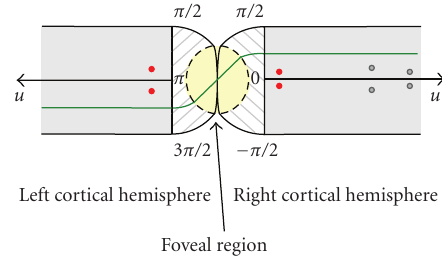
Figure 10: Schematic depiction of the global retinotopy with the peripheral region (gray) and the foveal region (yellow). Shaded in gray lines is the perifoveal region, which connects the other two regions. The red dots show the shifted neuronal activity in the receptive fields from the veridical position (gray dots) resulting in the illusory space